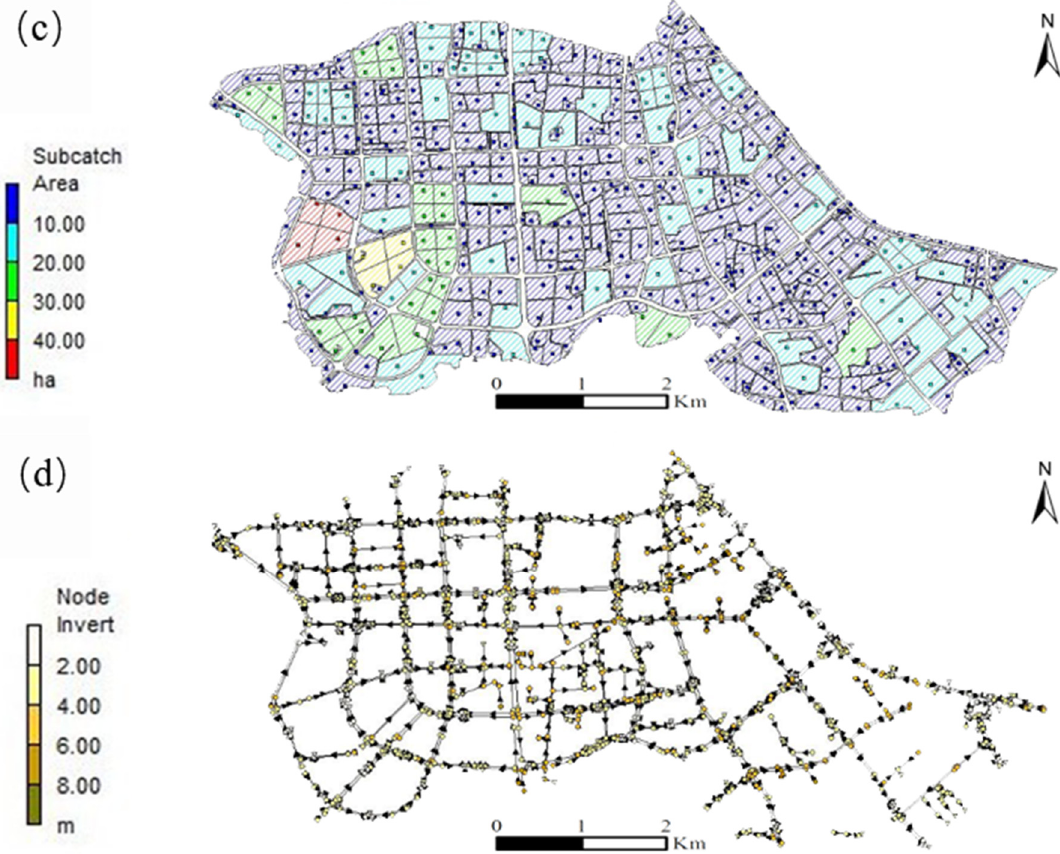
Figure 2. Key static variables and frames for Storm Water Management Model (SWMM). ( a ) DEM; ( b ) land use type; ( c ) sub-catchment of study area; ( d ) drainage system generalization of study area.